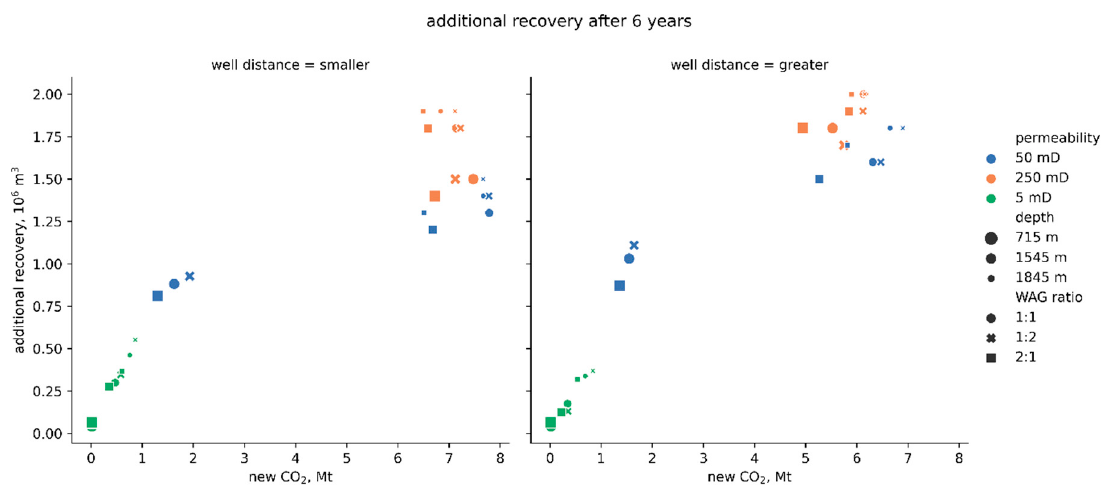
Figure A6. Additional recovery versus new CO 2 after 6 years of EOR.